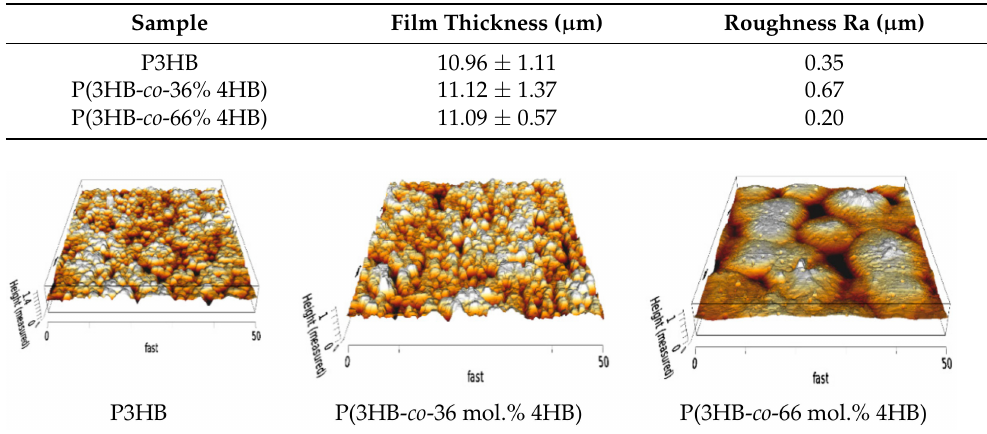
Figure 1. AFM surface morphology of prepared films illustrating the differences in the surface roughnesses of P3HB, P(3HB- co -36 mol.% 4HB) and P(3HB- co -66 mol.%